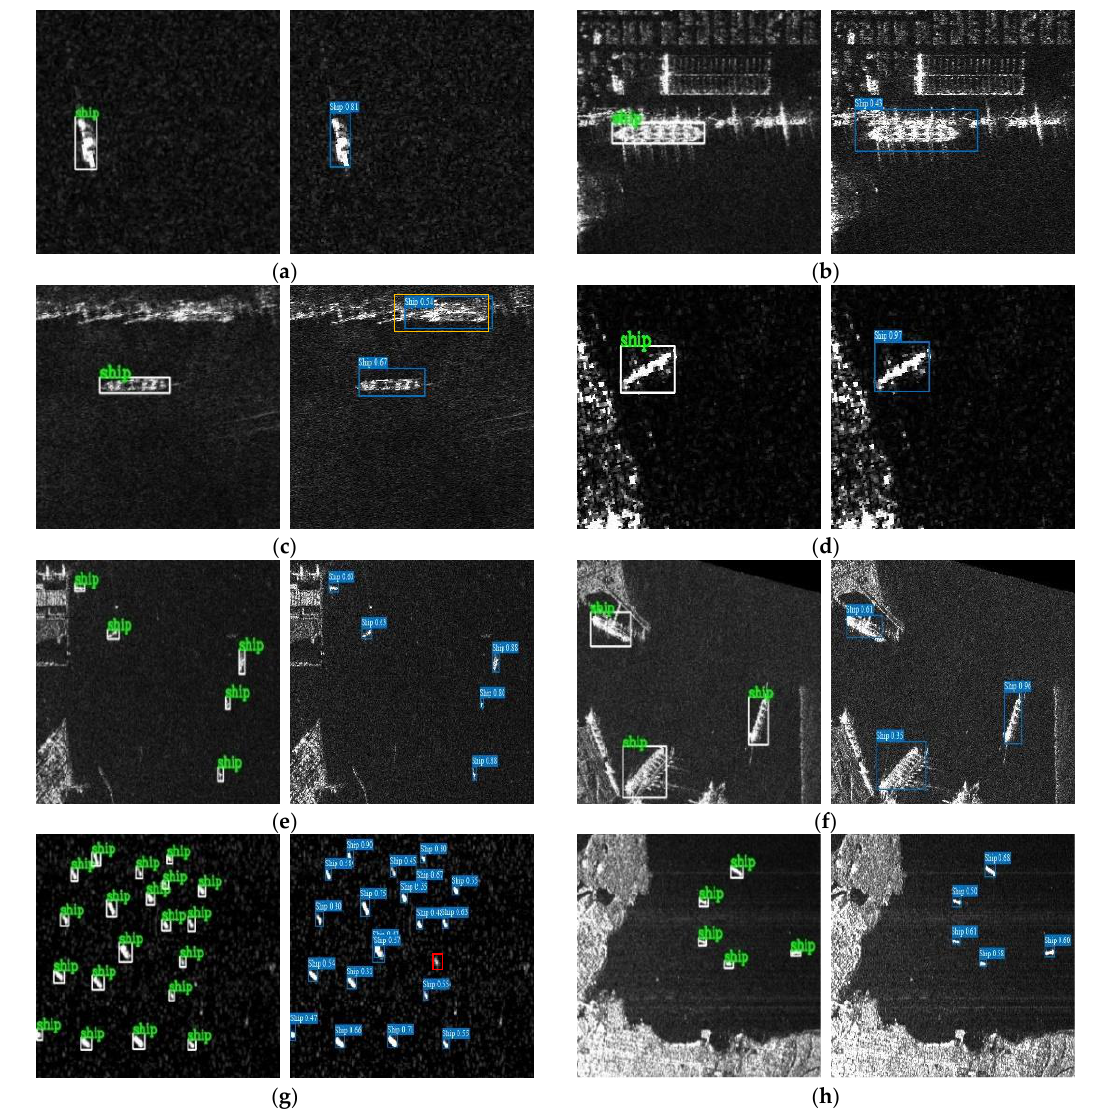
Figure 14. The ship detection results of some samples. ( a ) – ( h ) Various backgrounds. The ground truth is marked in green, the predicted boxes are marked in blue, miss-detection is marked in red, and false alarm is marked in yellow. Remote Sens. 2019 , 11 , x FOR PEER REVIEW